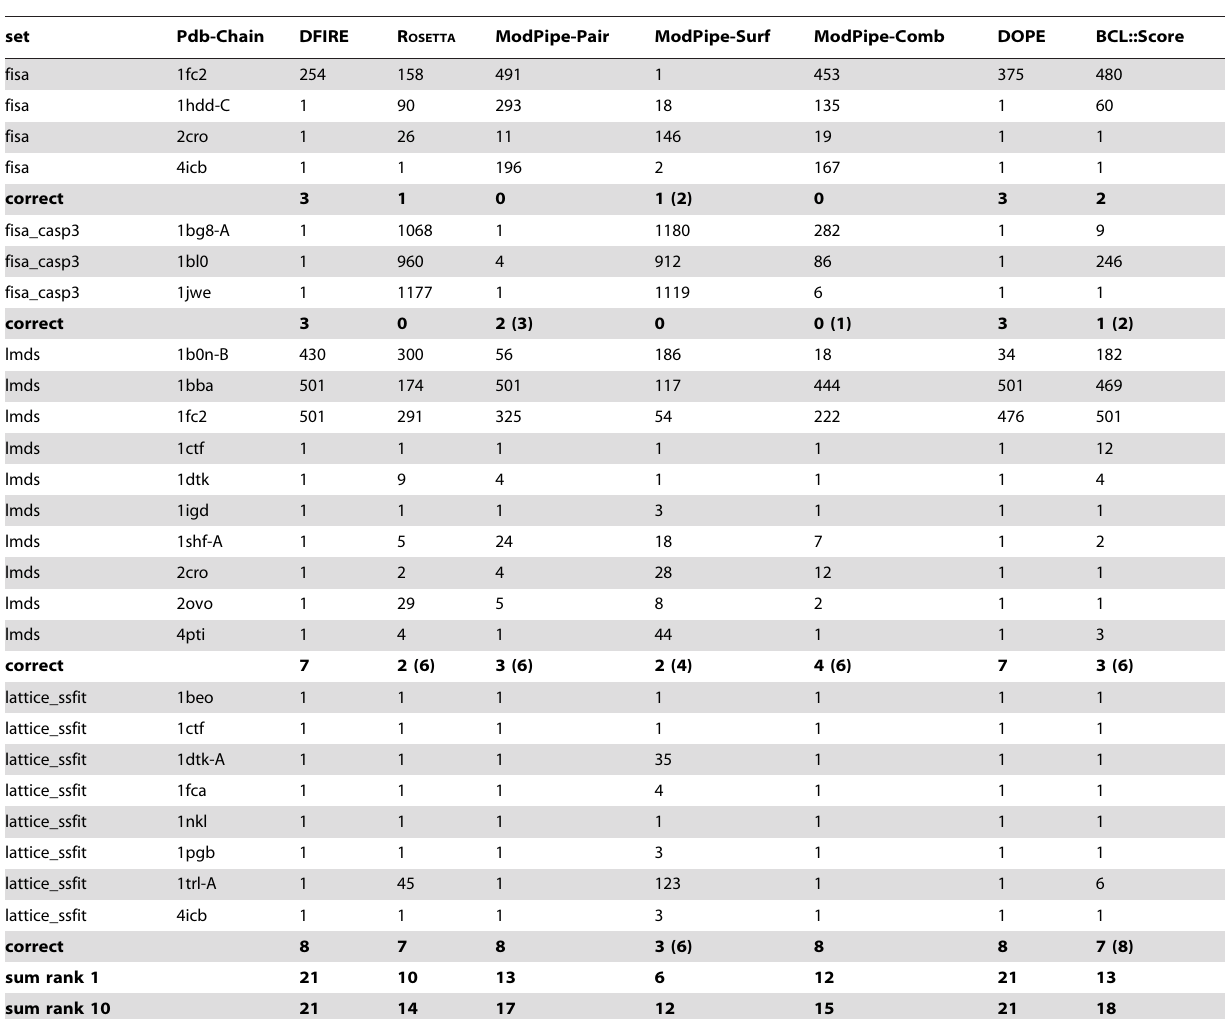
Table 4. Ranking of native structure within different decosy‘r’us model sets.